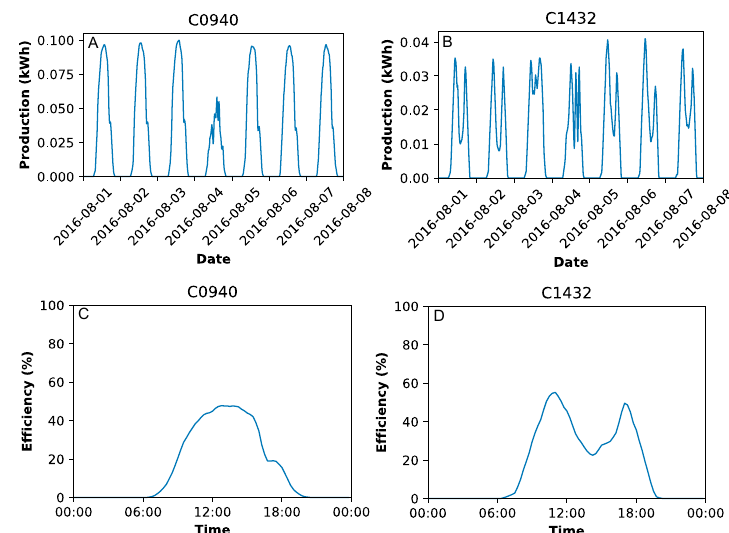
Figure 6. Two photovoltaic (PV) systems with contrasting daytime shading severity. Time-series of electricity production for ( A ) a PV system with mild daytime shading, and ( B ) a PV system with severe daytime shading. Weekly mean efficiency curves for ( C ) a PV system with mild daytime shading, and ( D ) a PV system with severe daytime shading.